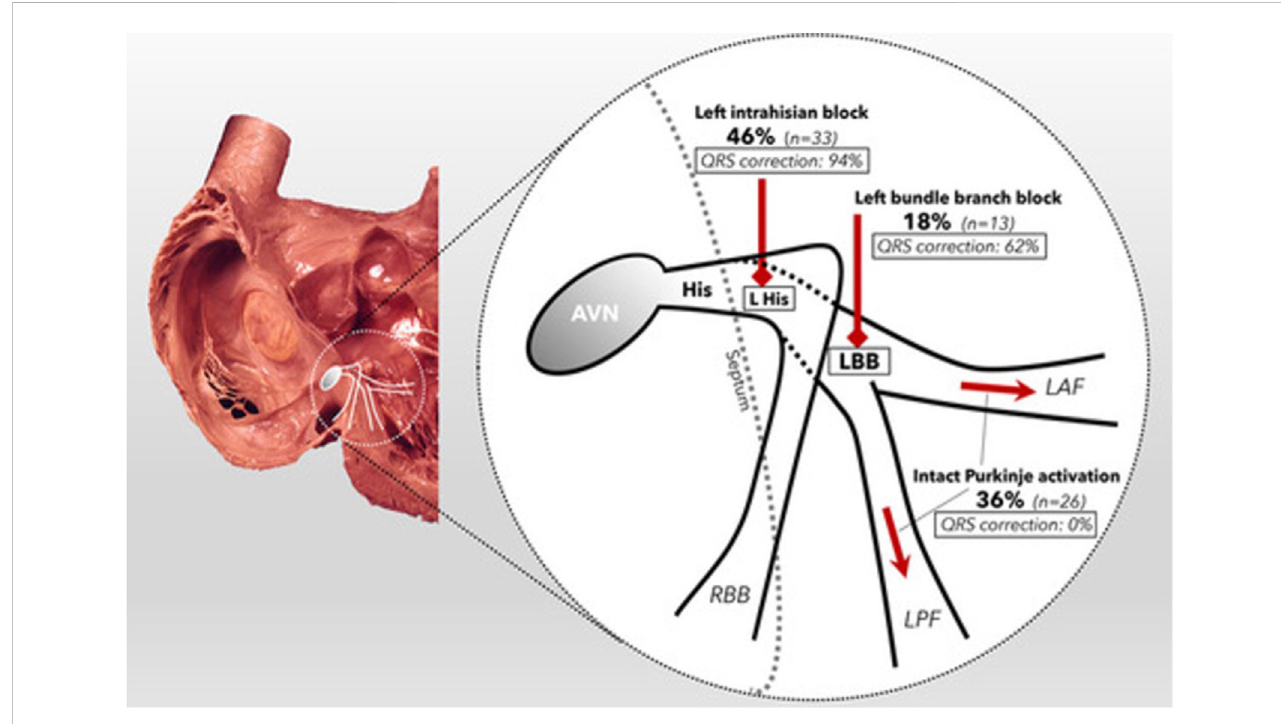
FIGURE 4 Schematic of the proximal conduction system, demonstrating the prevalence of each form of conduction disorder within the cohort (bold) and the percentage of patients whose QRSd was corrected by HBP (italic). Reproduced from reference 68, Upadhyay et al., with permission.